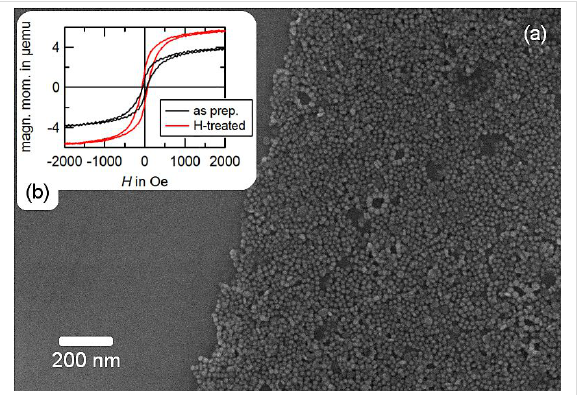
Figure 1: Monolayer of magnetic Co nanoparticles, species I. (a) SEM image of a two-dimensional particle assembly of 13.8 nm oleylamine- stabilized Co particles. (b) AGM measurements before and after hydrogen